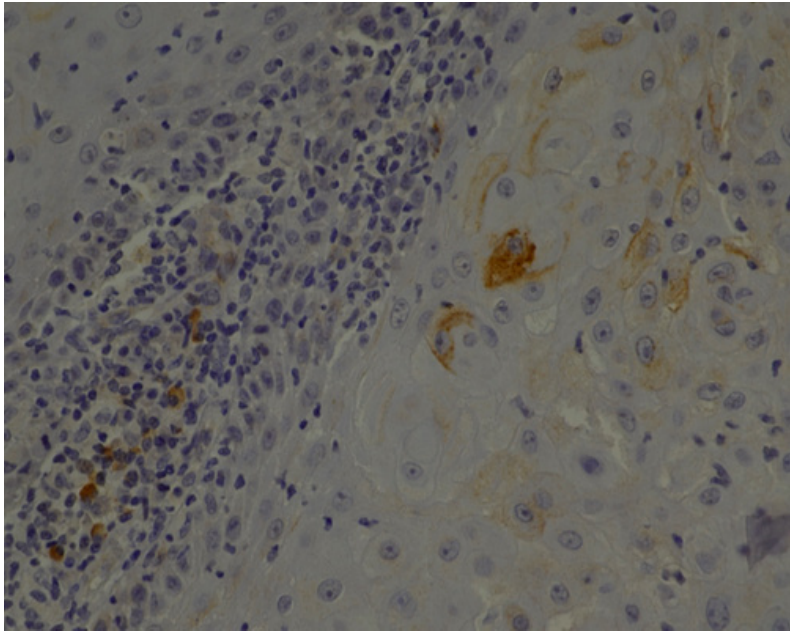
Figure 4. IL-8—moderate brown staining in epithelial cells and stroma of OSCC (40x).